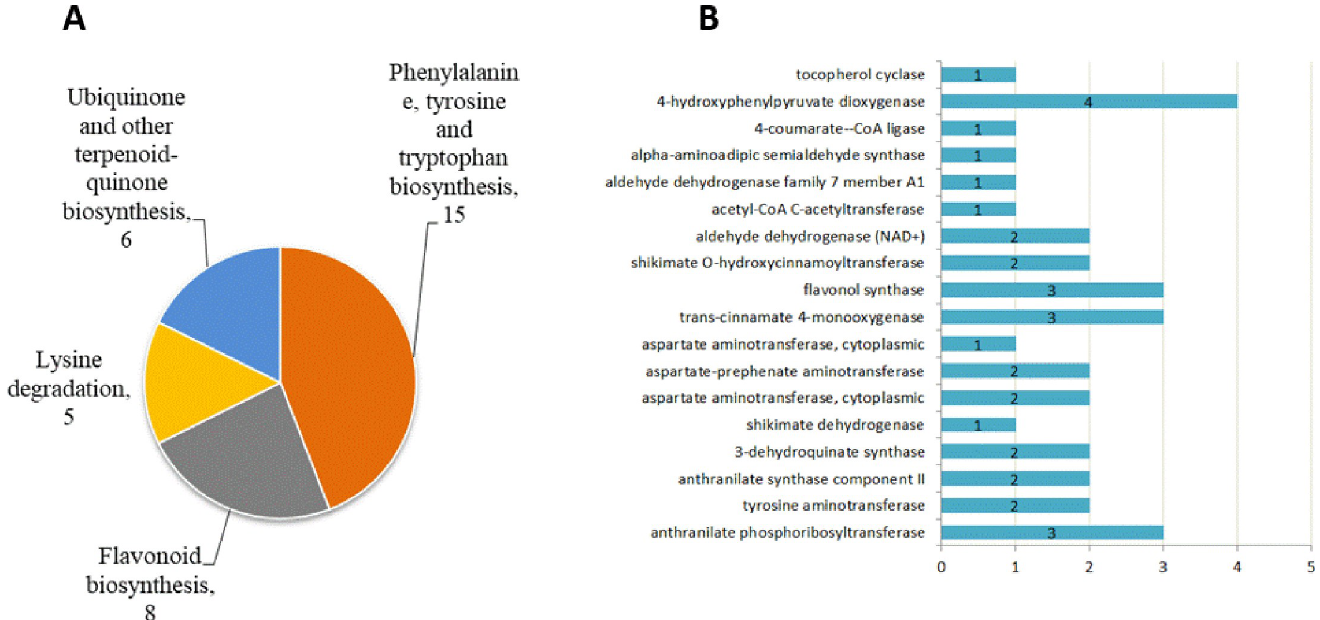
Fig 5. KO and GO annotation of DAPs in the candidate pathway correlated with cold tolerance of winter rapeseed. A: the candidate pathway and DAP numbers in each candidate pathway. B: GO annotation of DAPs, numbers in histogram indicate number of DAPs.